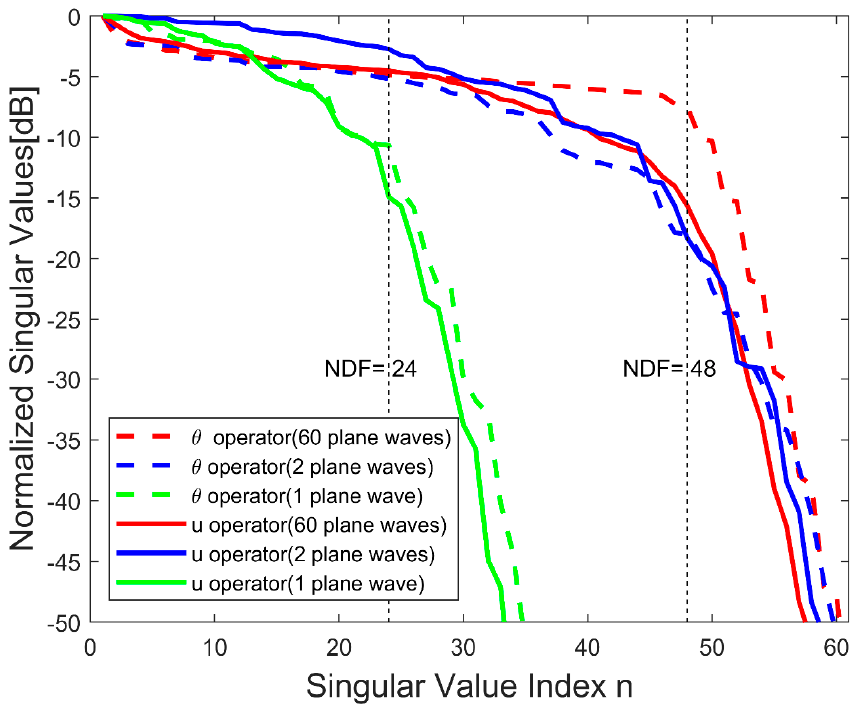
Figure 8. Normalized singular values of Equation (26) and relevant operator L u for different numbers of impinging plane waves.